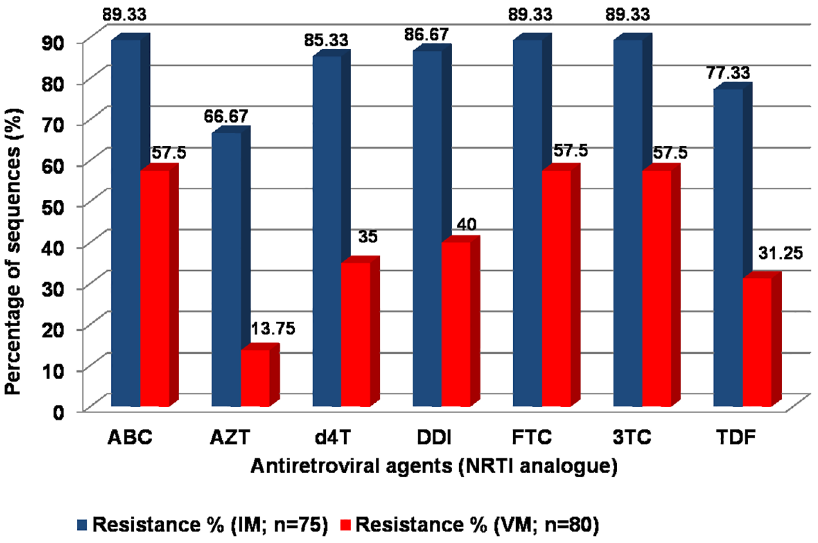
Fig 3. Predicted susceptibility to NRTI. The predicted susceptibilityto NRTI followingimmunological monitoring (IM; n = 75) is comparedwith those from individualswith virological failure detected by targeted viral load monitoring at 12 months of ART (VM; n =